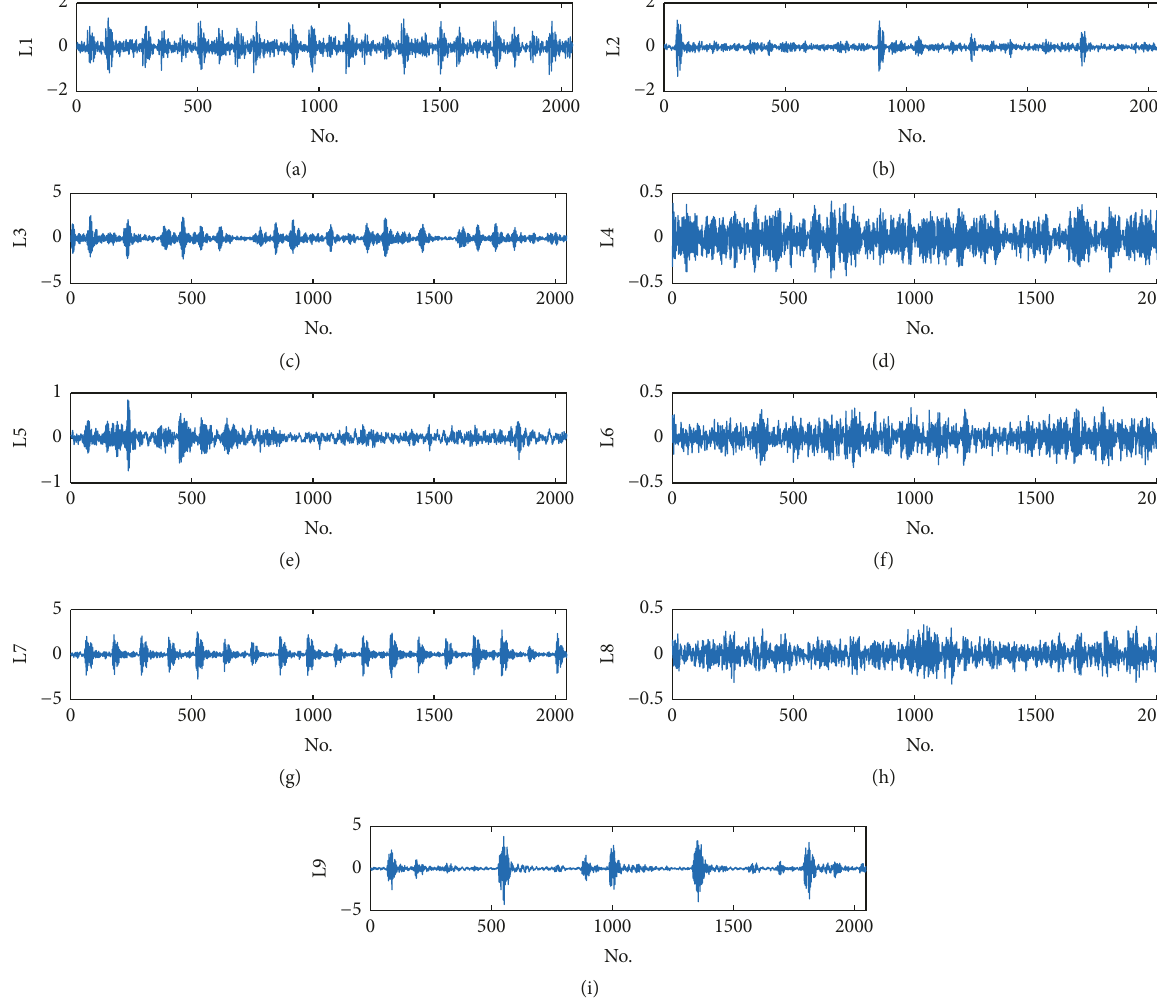
Figure 3: Time domain waveforms of signals with different faults: (a) inner race 0.007 inches, (b) inner race 0.014 inches, (c) inner race 0.021 inches, (d) ball 0.007 inches, (e) ball 0.014 inches, (f) ball 0.021 inches, (g) outer race 0.007 inches, (h) outer race 0.014 inches, (i) outer race 0.021